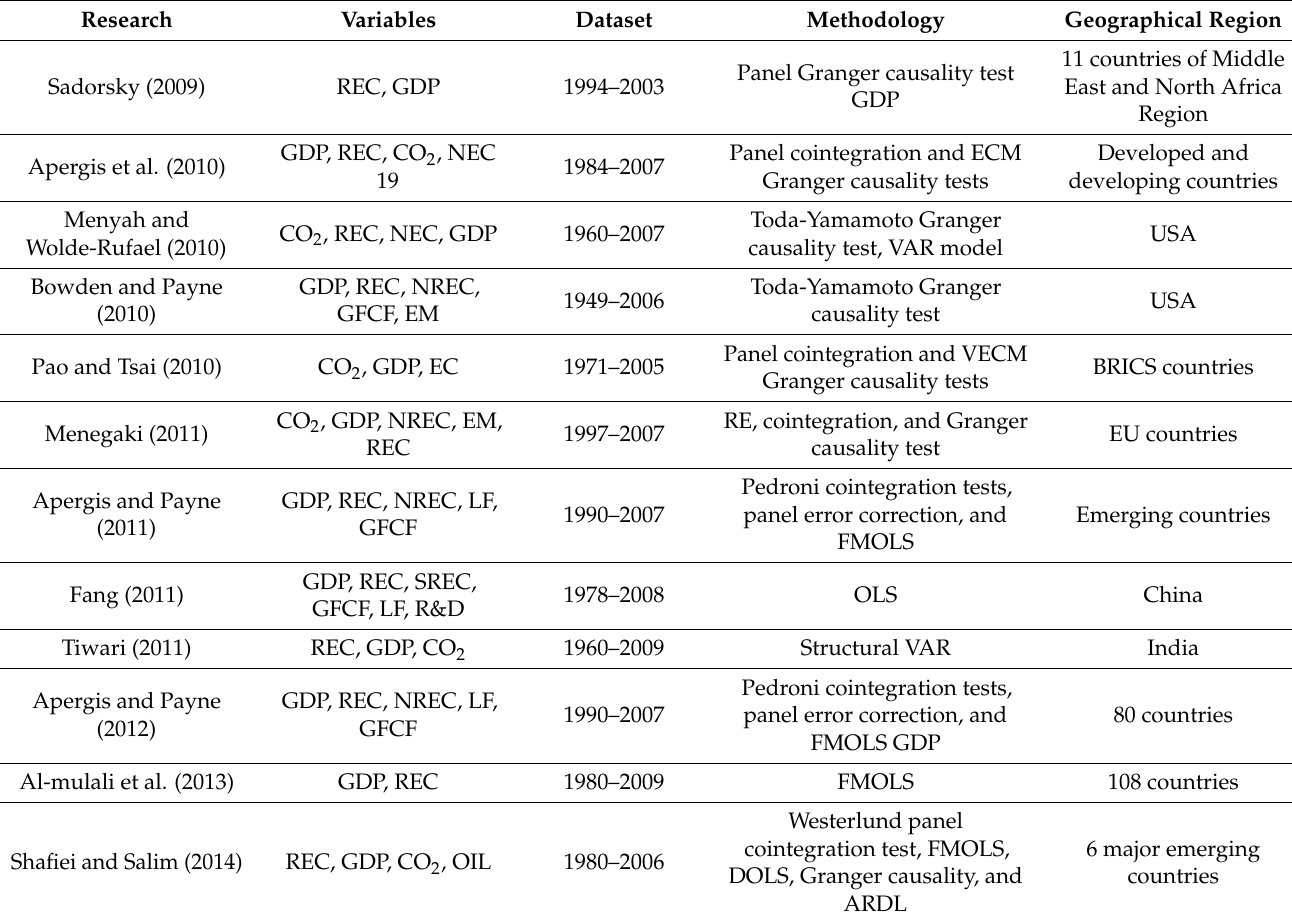
Table 1. Summary of